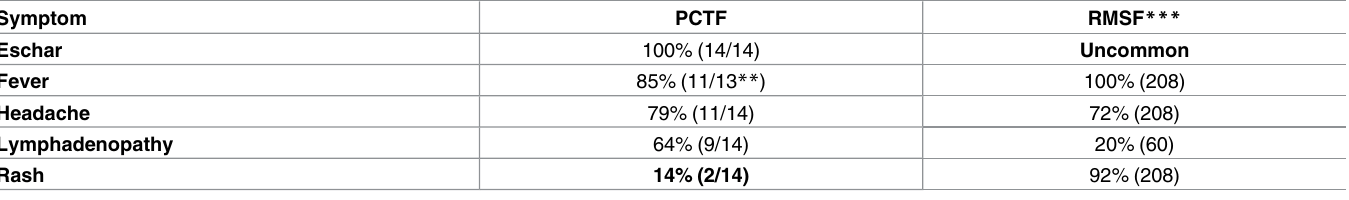
Table 1. Comparative symptomology associated with Pacific Coast tick fever (PCTF) and Rocky Mountain spotted fever (RMSF) * . Symptom PCTF RMSF *** Eschar 100% (14/14)